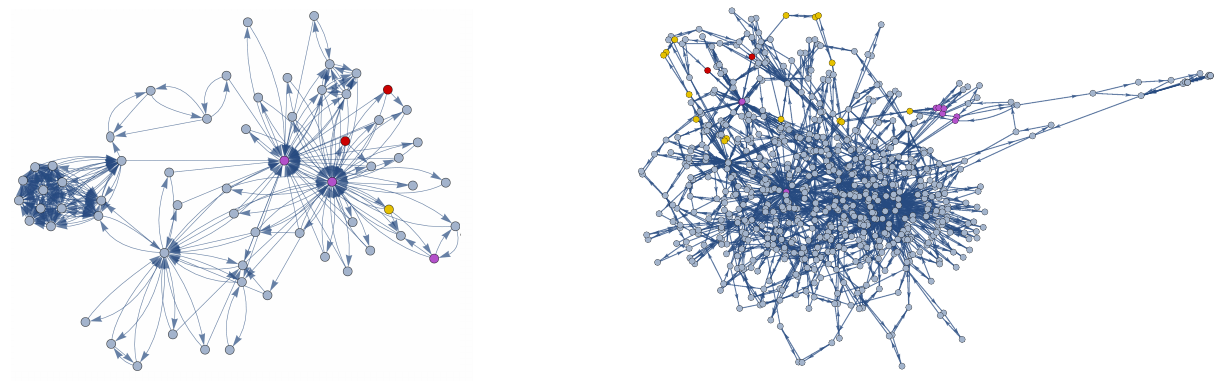
Fig. 4 (Left) A network representation of the largest strongly connected component of all Wikipedia webpages in the “logic puzzle” category [22]. Vertices represent webpages while the direct edges represent hyperlinks between them. Red vertices are symmetric and the yellow vertex is latently symmetric with the two red vertices. (Right) A Metabolic network of the eukaryotic organism Arabidopsis Thaliana [23]. Latently symmetric vertices are colored